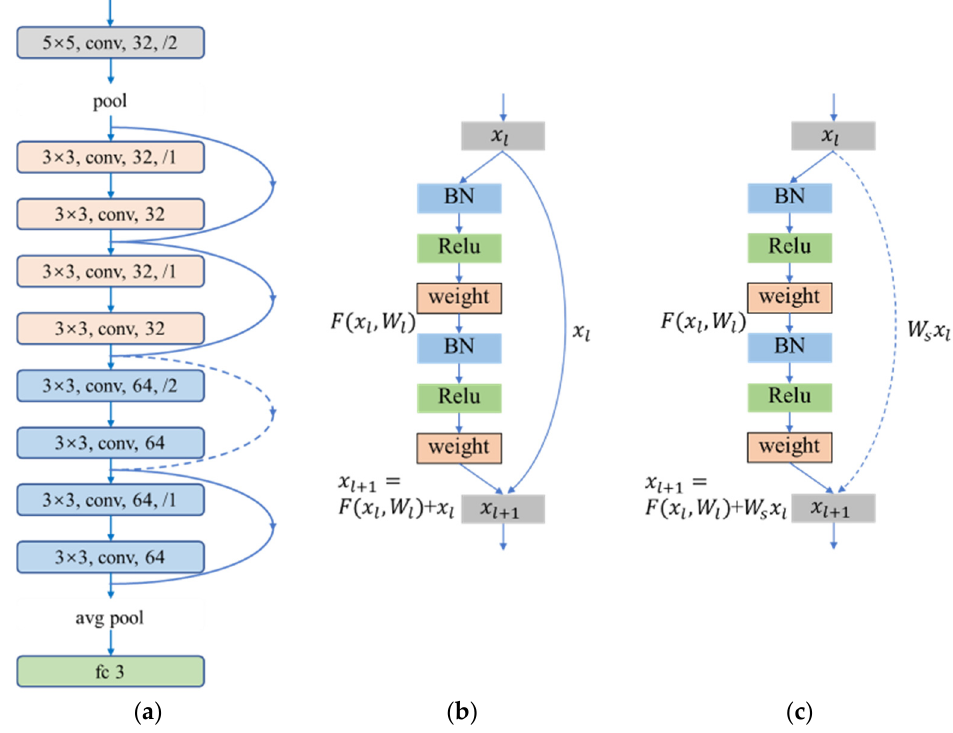
Figure 5. ( a ) Network framework of the MSI-ResNet model for ice classification of GF-3 synthetic aperture radar (SAR) data, ( b ) the block of solid line, and ( c ) the block of dotted line.